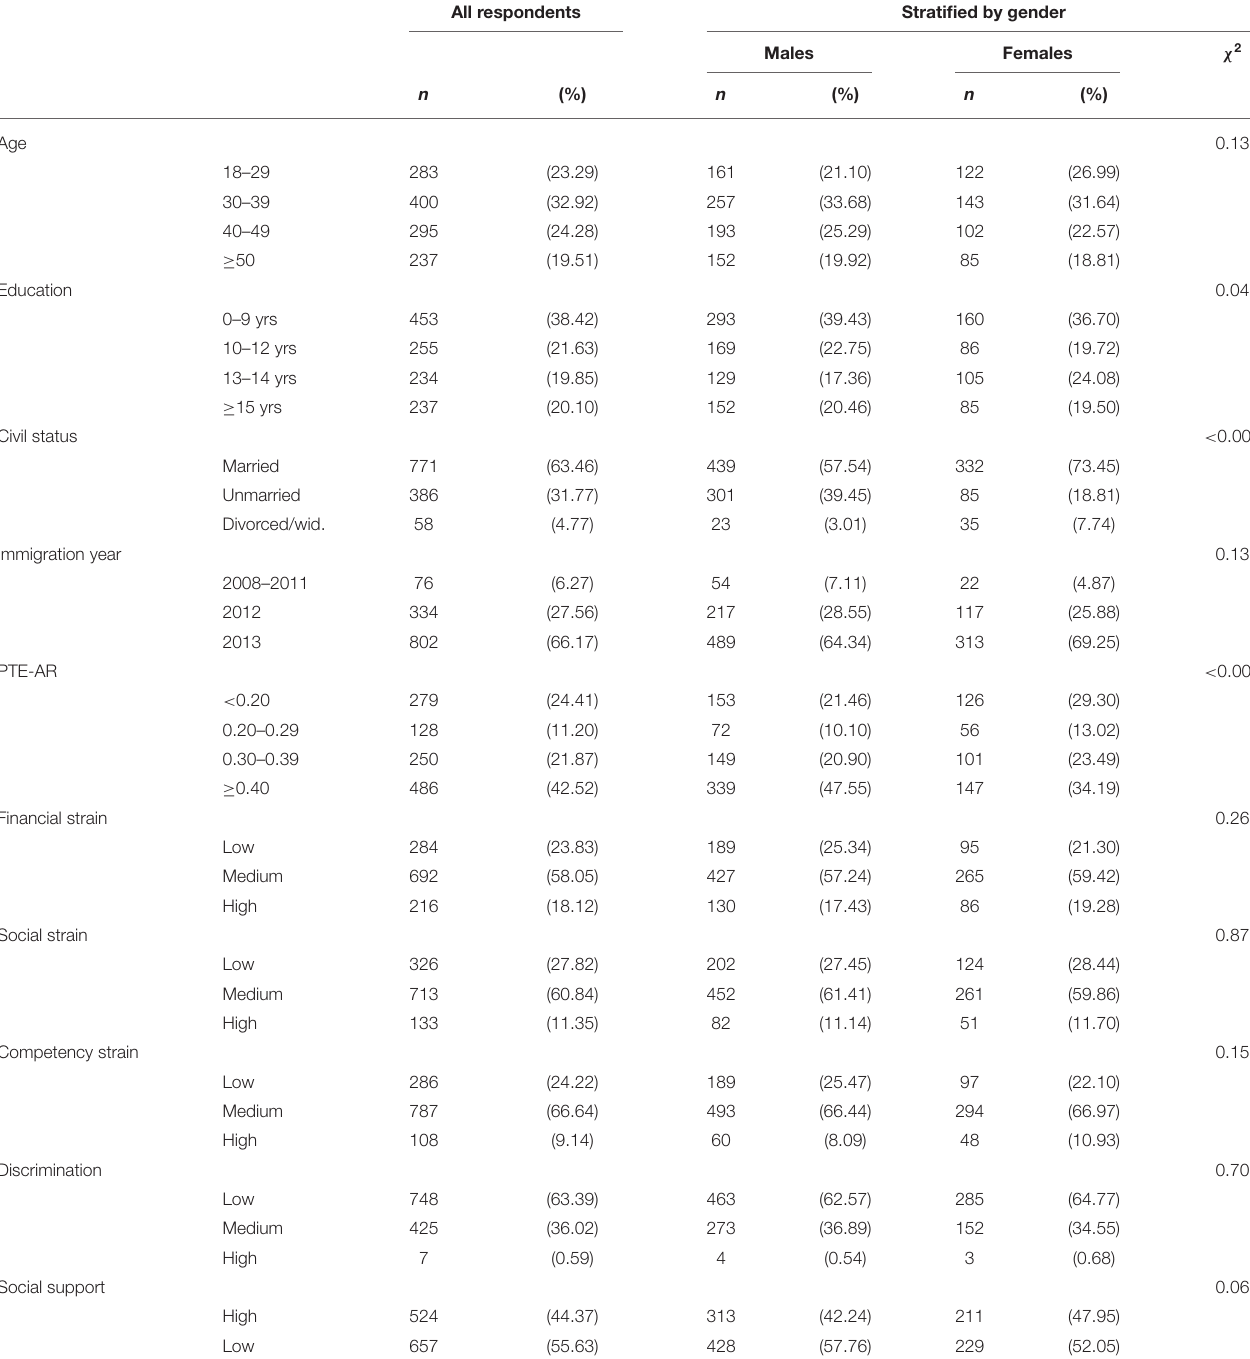
TABLE 1 | Descriptive statistics on background variables and post-migration stressors; bivariate association with